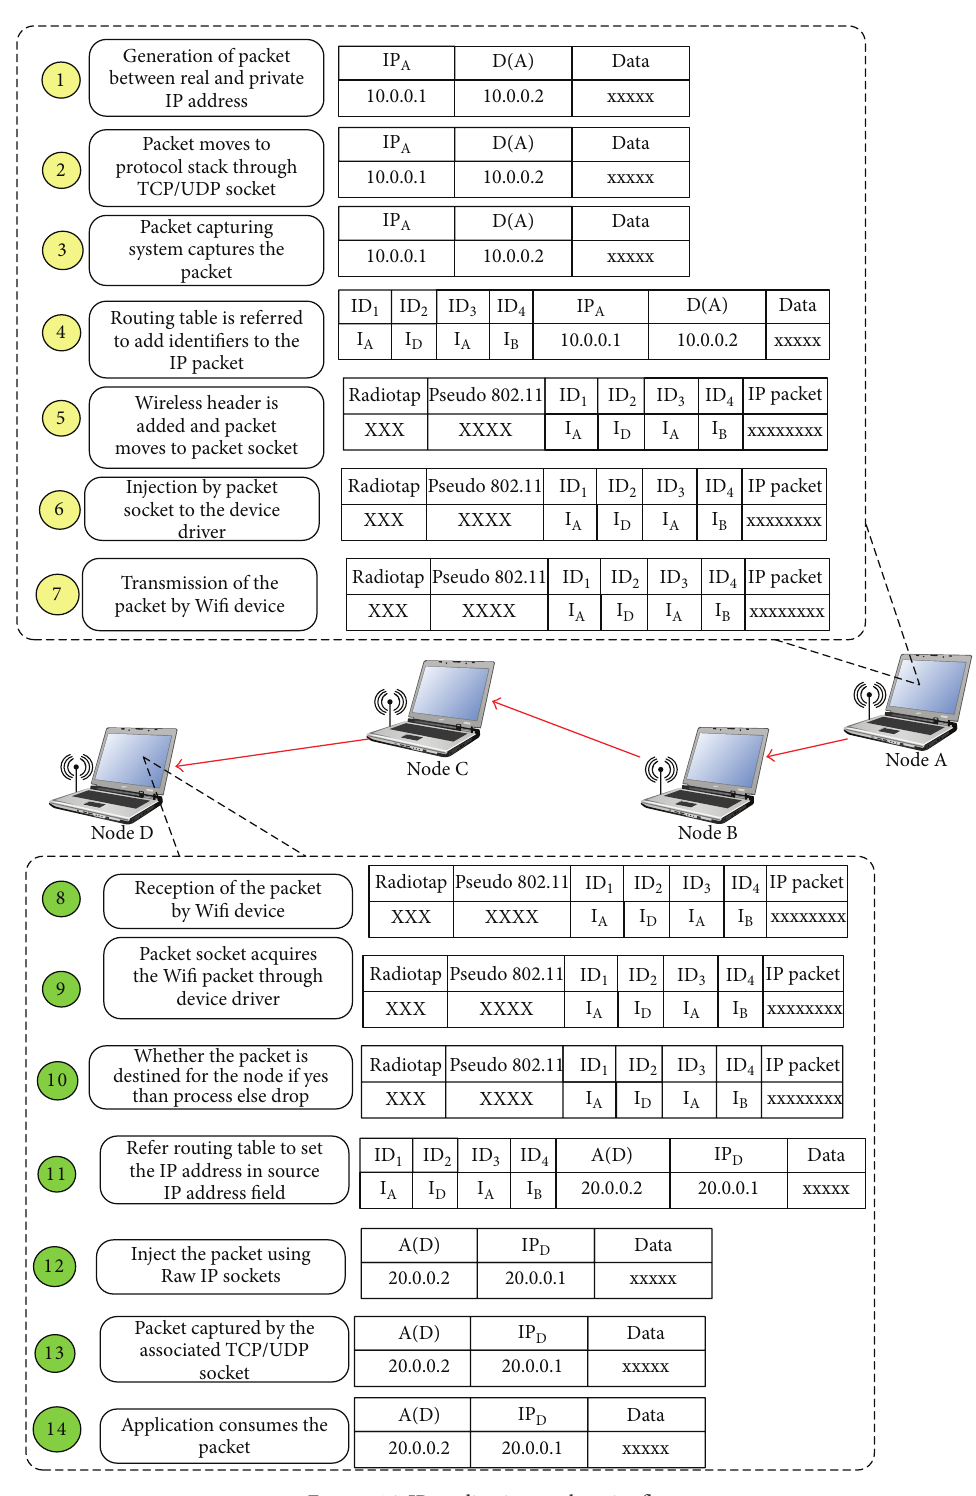
Figure 16: IP application packetwise